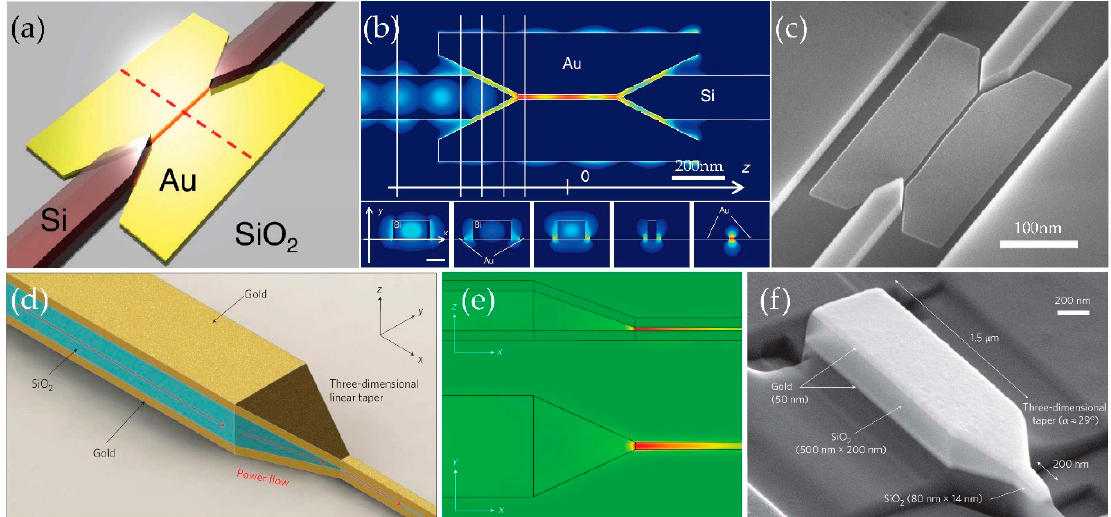
Figure 8. Tapered coupling design with reduction in both width and thickness. ( a – c ) A taper with large reduction in thickness for Si-strip waveguide to plasmonic slot waveguide mode conversion [121]. ( d – f ) A three-dimensional linear taper for highly efficient nanofocusing in MIM plasmonic waveguide [122]. ( a , d ) Schematics of the proposed tapers. ( b , e ) Field distributions. ( c , f ) SEM images of the fabricated tapers. Figures reproduced from ( a – c ) [121]; ( d – f ) [122]. Table 3. Summary of reported taper design for coupling silicon waveguides with plasmonic waveguides. Ref. Dielectric Waveguide Type and Core